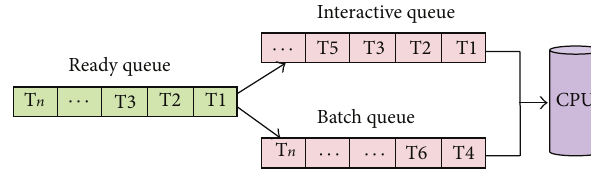
Figure 1: Multilevel queue